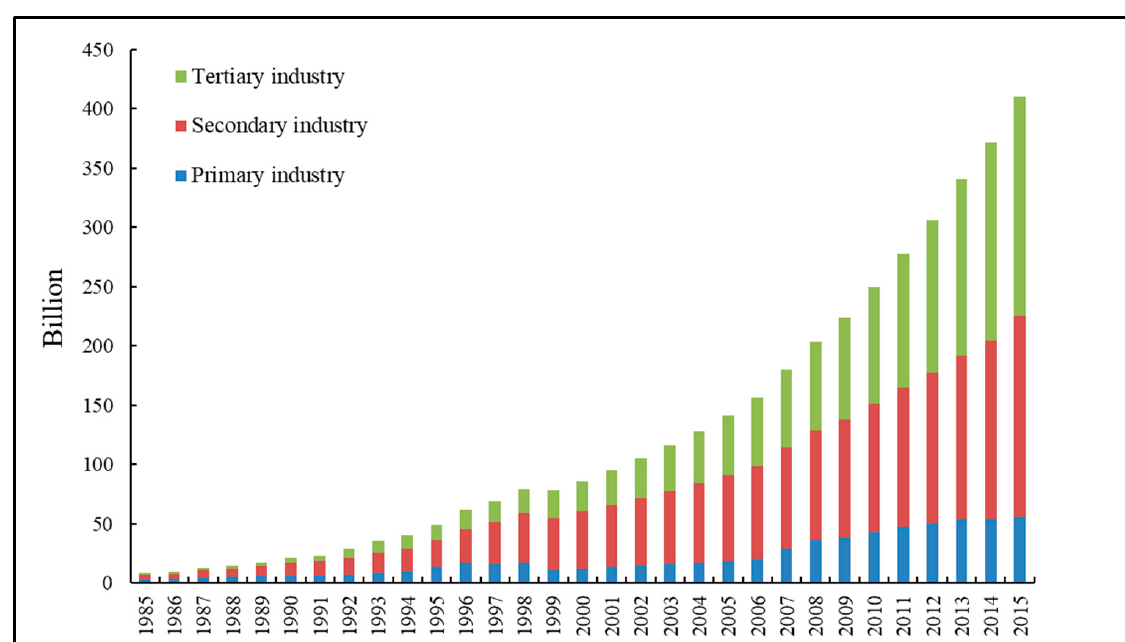
Figure A1. Industry proportion map of Xintai.